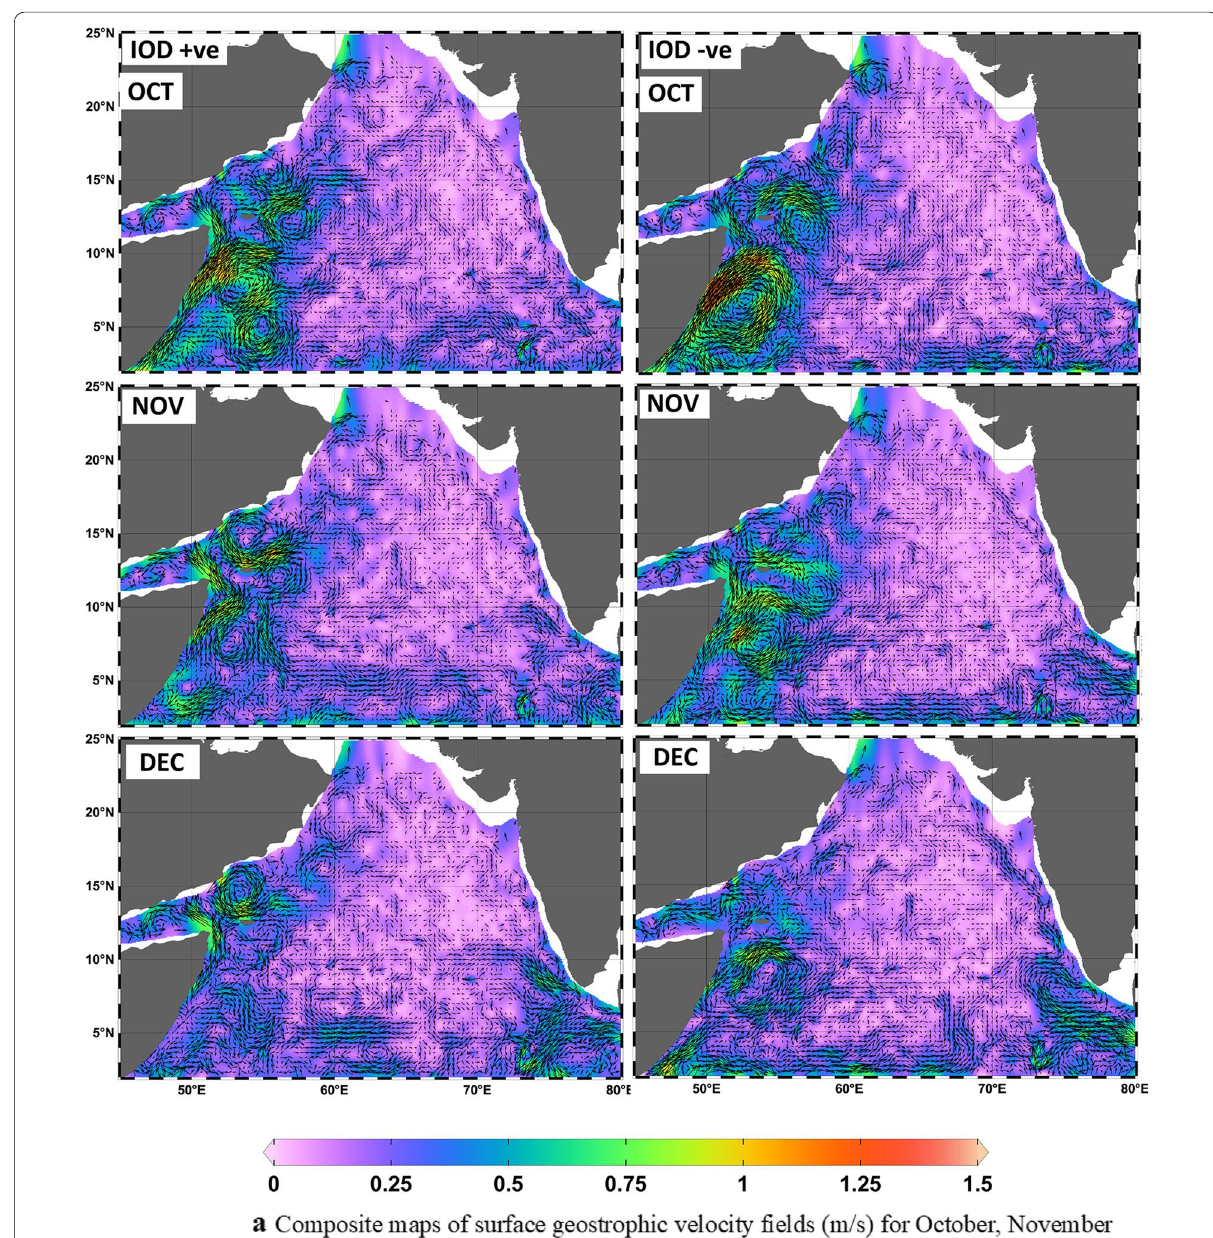
Fig. 9 a Composite maps of surface geostrophic velocity fields (m/s) for October, November and December in positive and negative IOD years. b Maps of mean surface geostrophic velocity fields (m/s) in the equatorial region in October and November. The upper two panels are for 1996 and lower two panels are for 1997. c Zonal distribution of zonal components of velocity (positive, eastward; in m/s) at 60ºE, 65° E and 70° E in November of 1996 and 1997. d Maps of mean geostrophic velocity fields (m/s) in December of 1996 and 1997. Upper panels are for the eastern AS and lower panels, the western AS. e Maps of mean wind field (m/s) in November and December. Left panels are for 1996 and right panels,